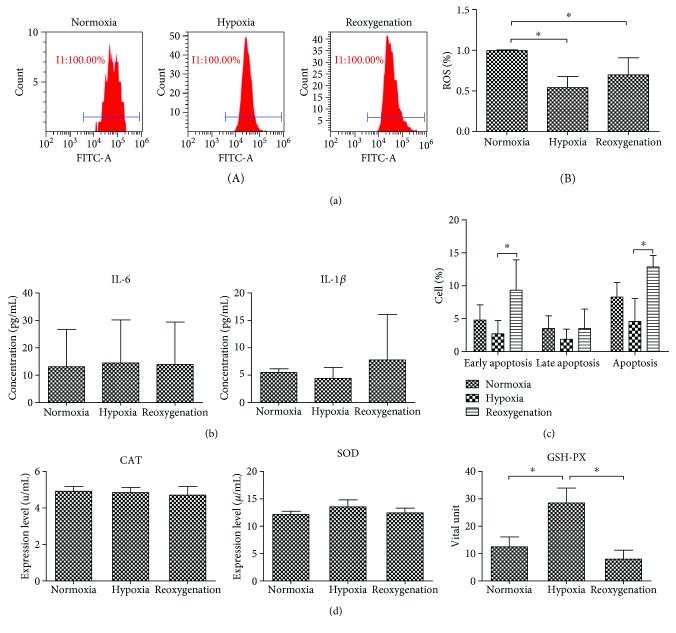
Effect of HP on oxidative stress in hDPCs after 3 d culture under normoxia, hypoxia, and reoxygenation: (a) HP-treated hDPCs were stained with 10 μM DCFDA and analyzed by flow cytometry; (b) the expression of inflammatory cytokines in each group, as analyzed by ELISA; (c) flow cytometry and quantitative analysis of cell apoptosis ratio in each group; (d) activity of the antioxidant enzymes SOD, CAT, and GSH-PX in hDPCs during culture at different oxygen concentrations. Statistical significance is expressed as ∗
p < 0.05.